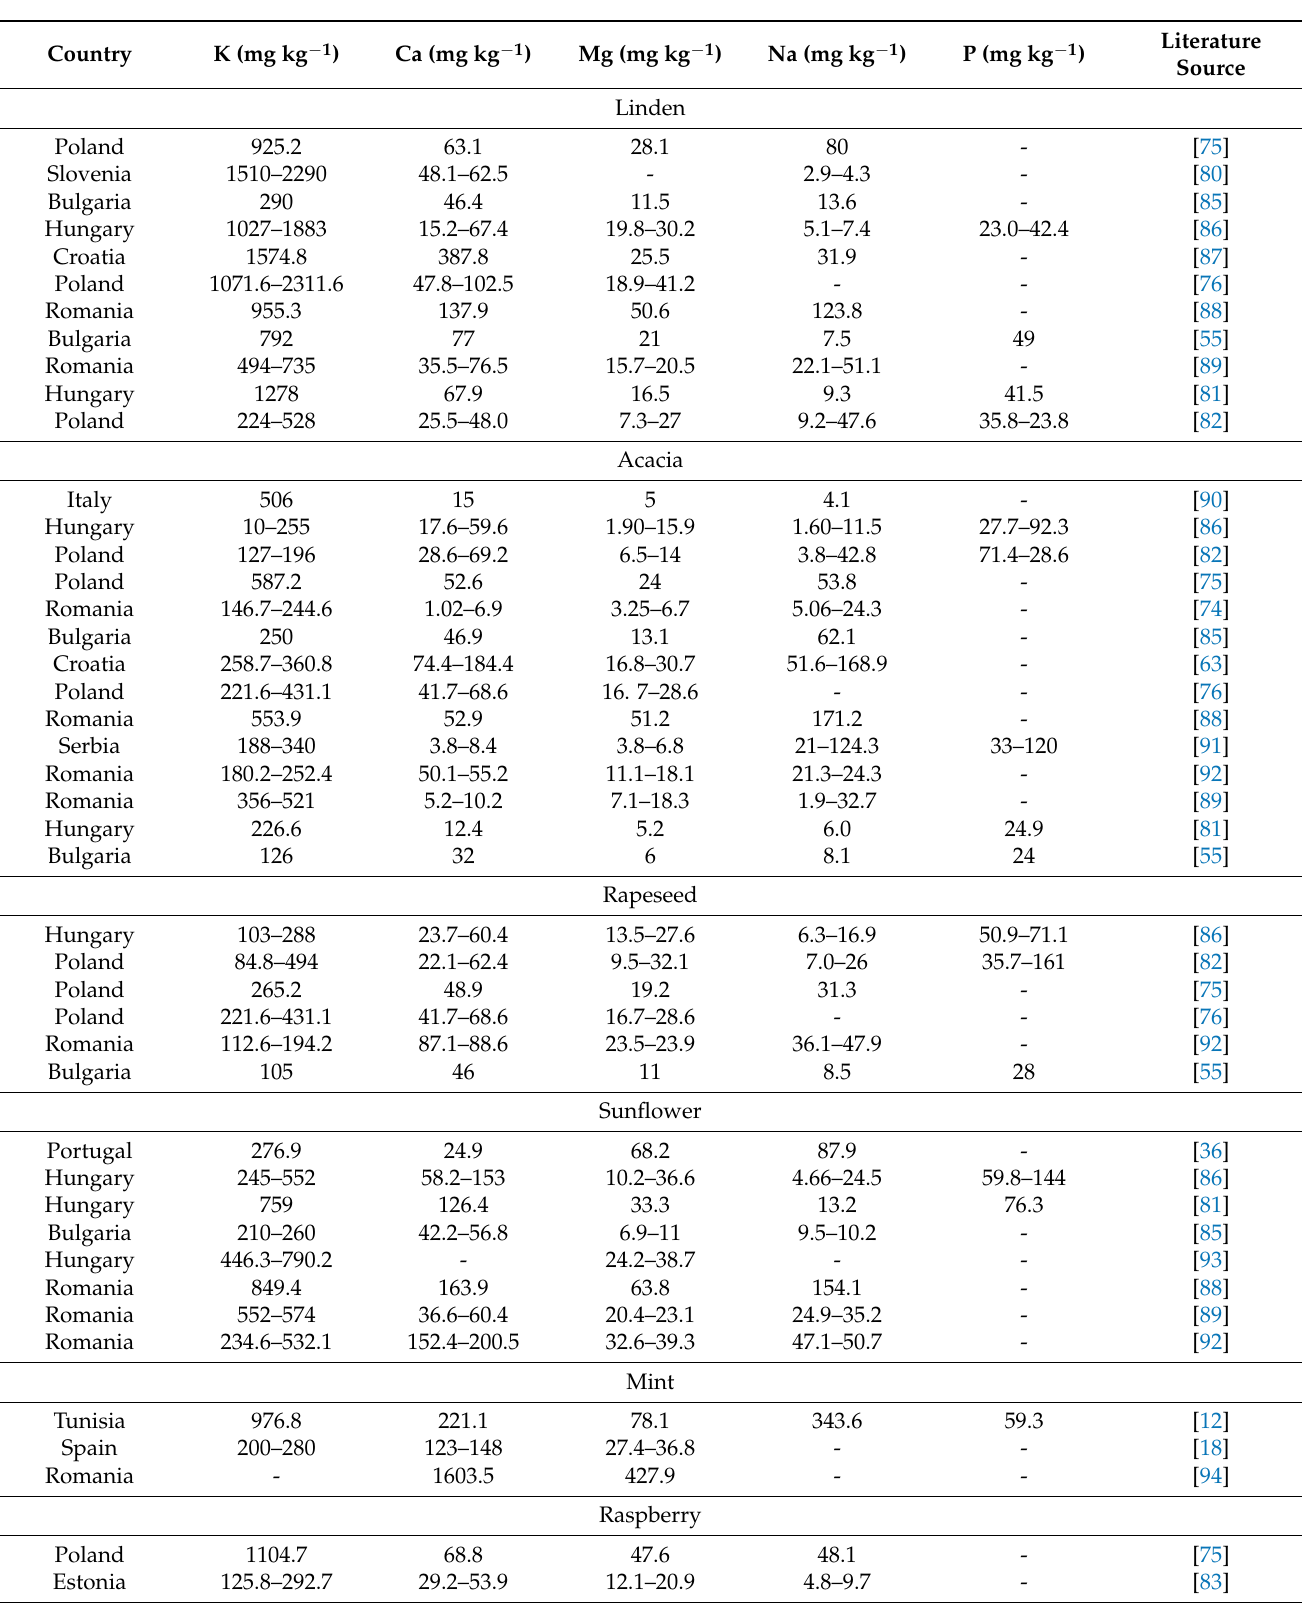
Table 11. Mineral elements of the seven floral